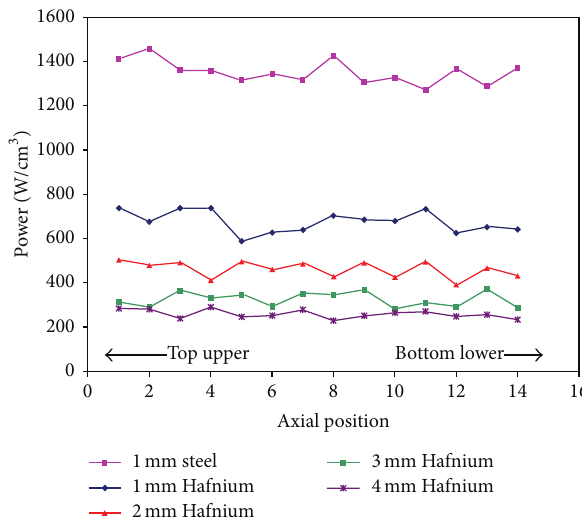
Figure 10: The influence of the thickness of the Hf shield on the power density in the two fuel pins [3].